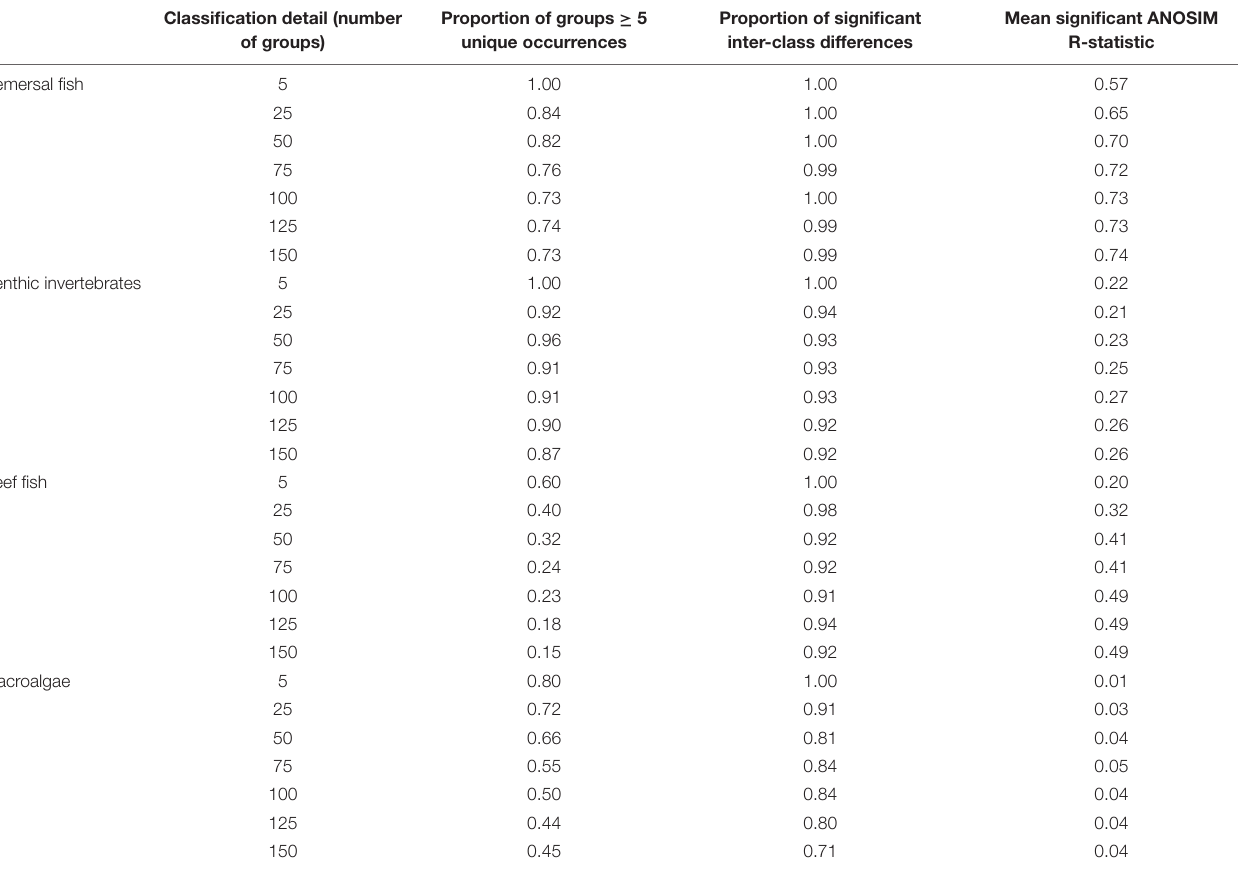
TABLE 2 | Results of the pair-wise analysis of similarities test (ANOSIM) analysis for the biotic groups at varying levels of classification detail. Classification detail (number of